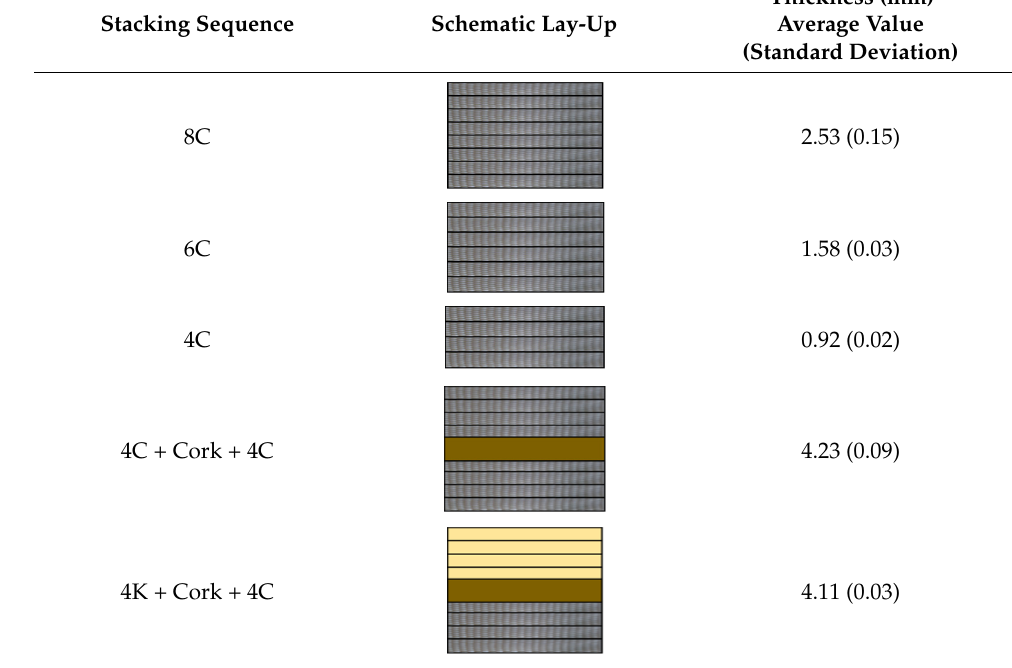
Table 1. Stacking sequences and thicknesses of the samples tested.